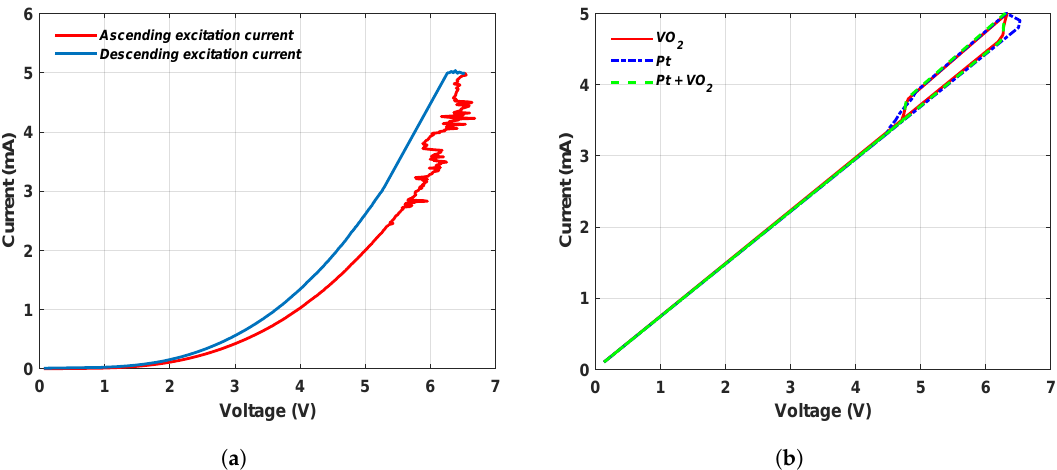
Figure 10. V-I curve of ( r = 10µm, h = 50nm) vertical VO 2 resistor based on: ( a ) Laboratory measurement. ( b ) Simulation results.